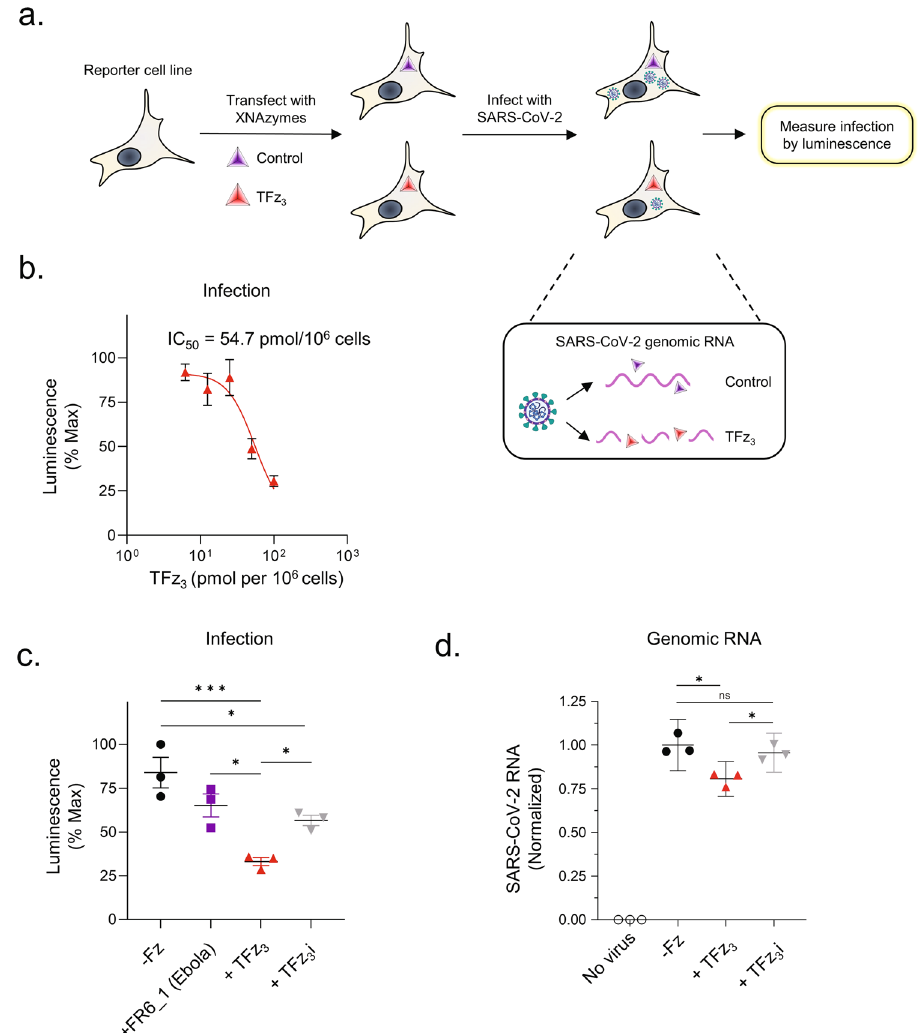
Fig. 3 | SARS-CoV-2 XNAzymes inhibit viral infection in cells. a Schematic showing theexperimentaldesignusedto evaluate XNAzymeactivityagainst SARS- CoV-2 infection. Luminescent HEK293T reporter cells 50 express an inactive, fi re fl y luciferase-basedbiosensor,activatedbyproteolyticcleavageduringviralinfection. b InhibitionofSARS-CoV-2infectionbythefully-FANATFz 3 catalyticnanostructure ( ’ TFz 3 ’ ). Reporter cells were transfected with the indicated doses of TFz 3 (red tri- angles), then infected with SARS-CoV-2 at MOI=0.01. Levels of infection were quantitated by luminometry after 16h. Mean values±SEM are shown for an experiment conducted in triplicate, representative of two independent experi- ments. c Speci fi city of inhibition by TFz 3 . Reporter cells were transfected with buffer alone ( − Fz) (black circles) or (50pmol per 10 6 cells) control XNAzyme ( ’ FR6_1 ’ ,targetinganRNAsequencefromEbola 31 )(purplesquares),activeTFz 3 (red triangles), or a version of TFz 3 containing catalytically inactive mutant XNAzymes ( ’ TFz 3 i ’ ) (grey triangles), then infected with SARS-CoV-2 at MOI=0.01. Levels of infection were quantitated by luminometry after 16h. Horizontal bars and error